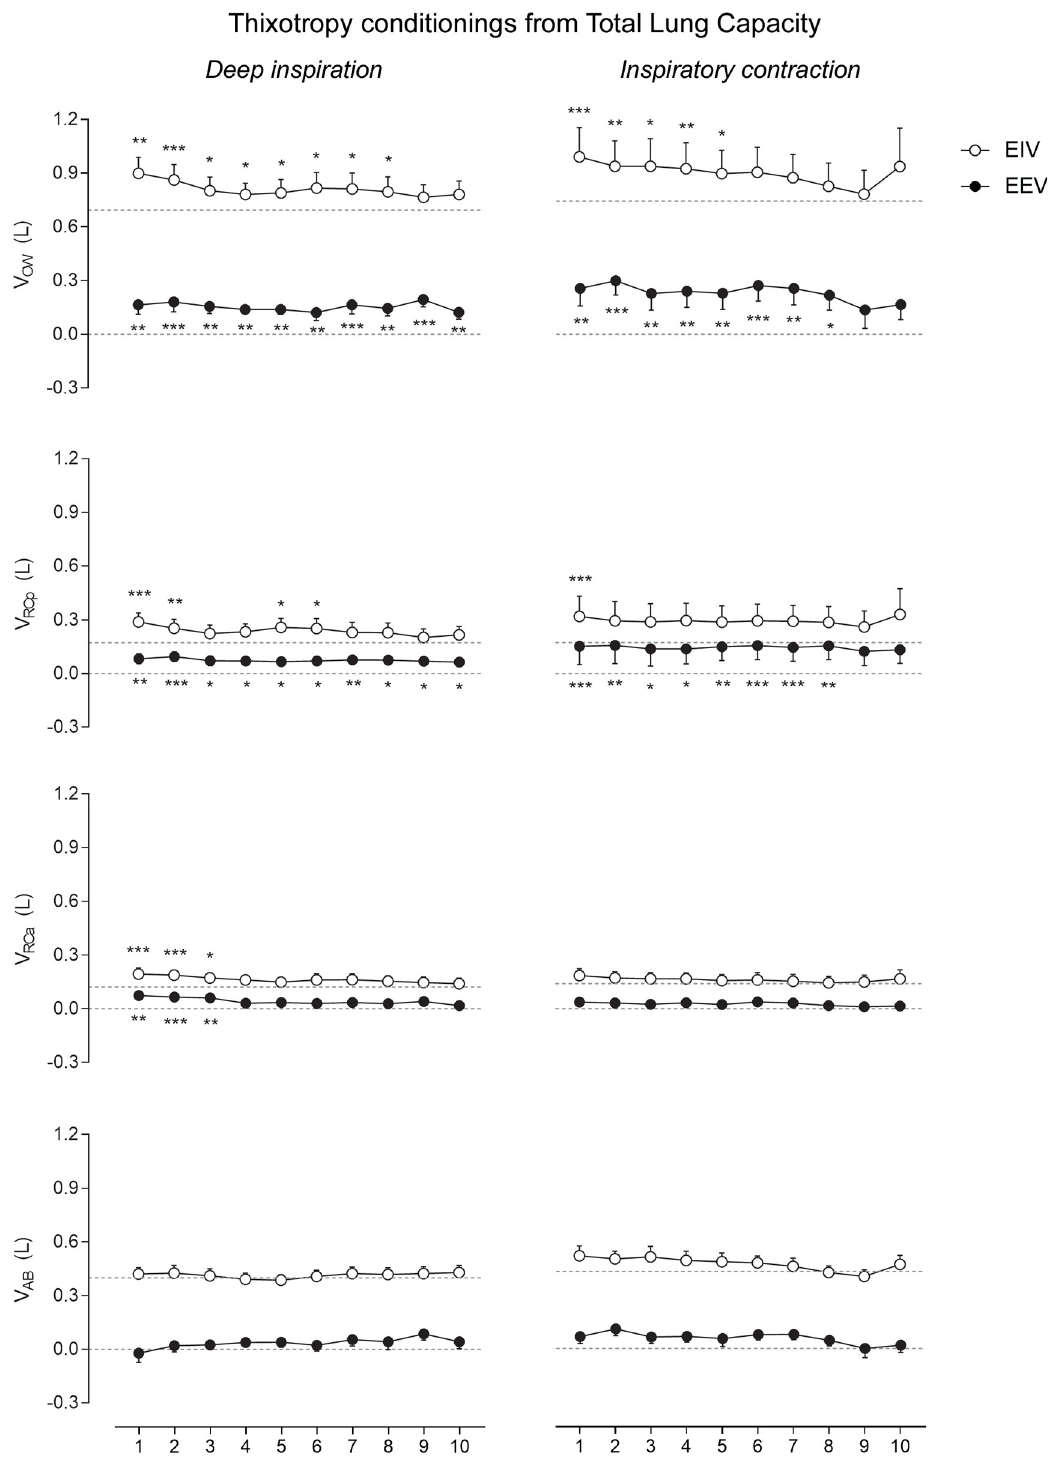
Fig 2. After-effects of thixotropic conditionings performed from total lung capacity on end-inspiratory (EIV) and end- expiratory (EEV) volumes of the chest wall (CW) and its compartments (pulmonary ribcage [RCp], abdominal ribcage [RCa] and abdominal [AB]). Data of the first ten respiratory cycles (x-axis) immediately after the conditionings were compared with mean values (mean of the 60 seconds) of quiet breathing (dotted lines) performed before the maneuvers. Data are shown as mean ± SE. L: Liters; ��� p < .0001, �� p < .001, and � p < .05 compared with quiet breathing using one-way ANOVA (CW, RCp, and RCa) and Friedman test (AB), and Dunn’s post hoc test. https://doi.org/10.1371/journal.pone.0275584.g002 PLOS ONE | https://doi.org/10.1371/journal.pone.0275584 October 14,